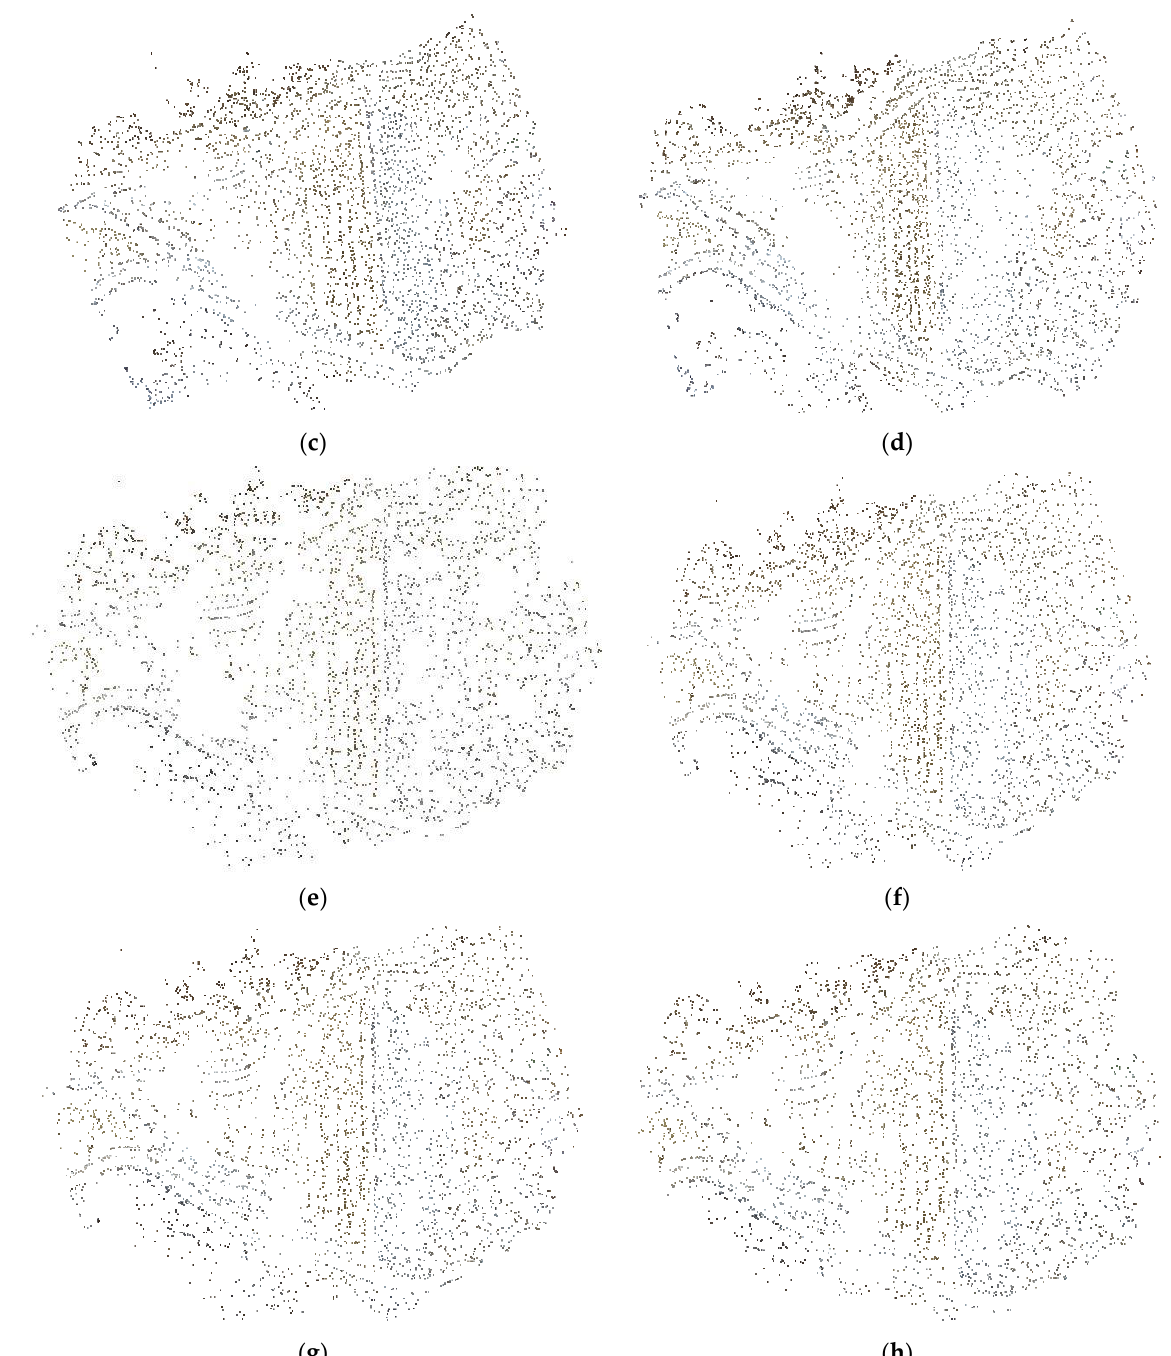
Figure 4. Feature point extraction using scale-invariant feature transform (SIFT) matching: ( a ) case 1, ( b ) case 2, ( c ) case 3, ( d ) case 4, ( e ) case 5, ( f ) case 6, ( g ) case 7, and ( h ) case 8.